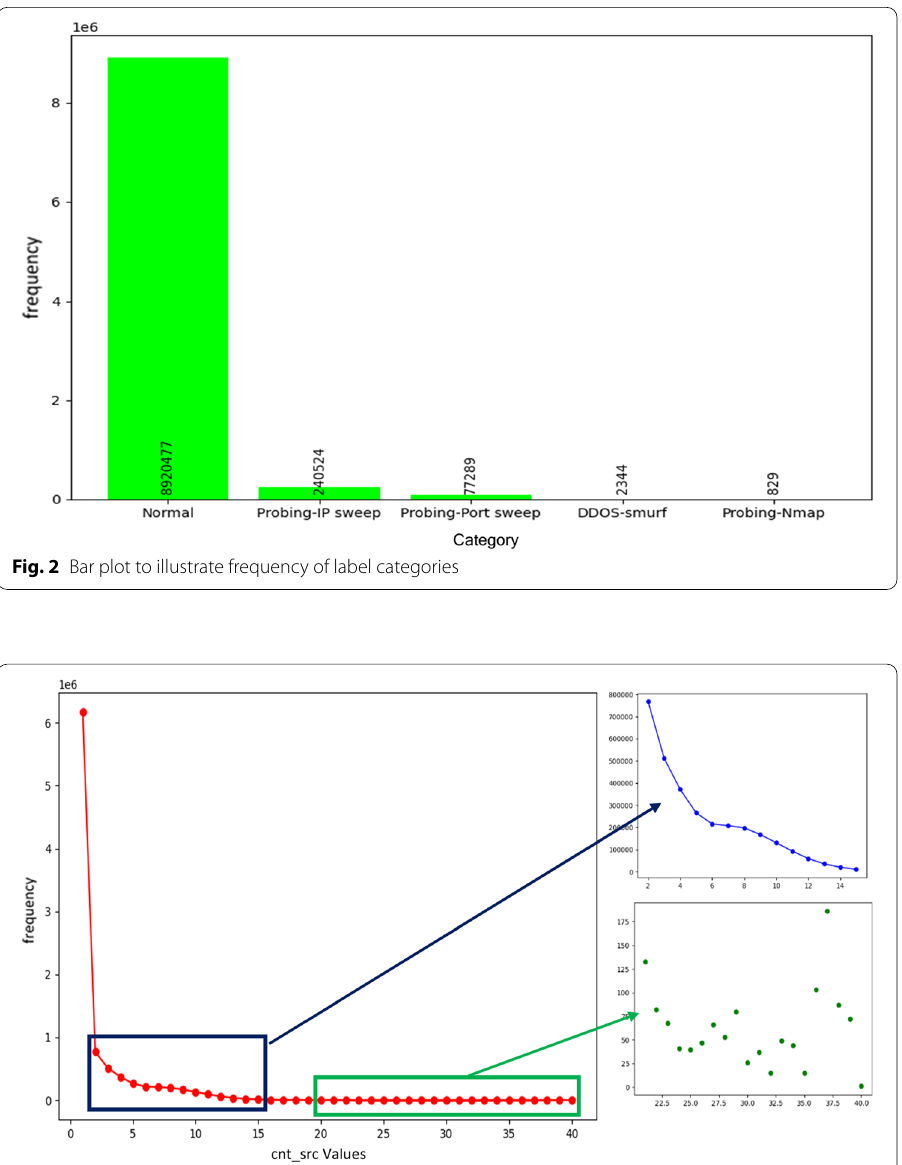
Fig. 3 The frequency of cnt_src column